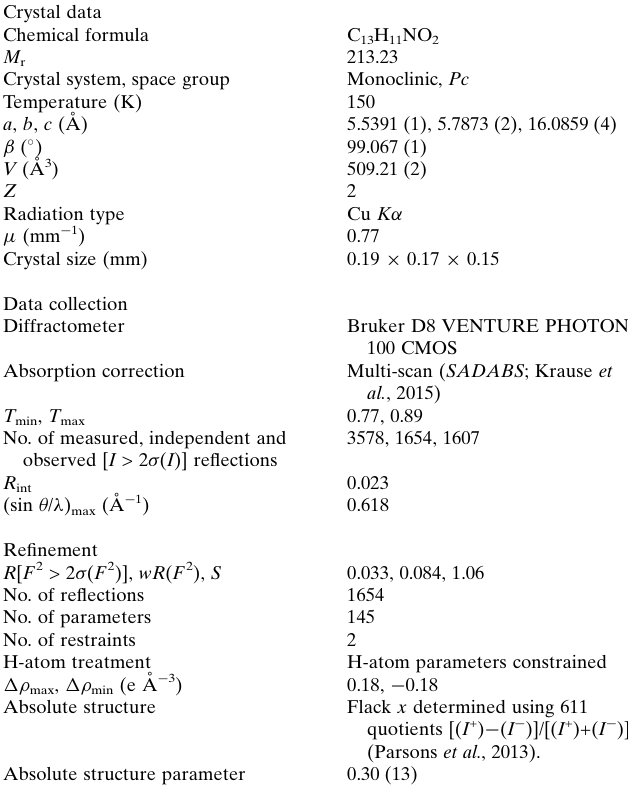
Table 4 Experimental details. Crystal data Chemical